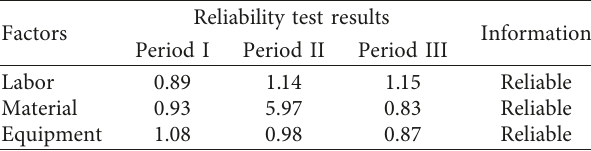
Table 8: Result of the reliability test of data frequency.